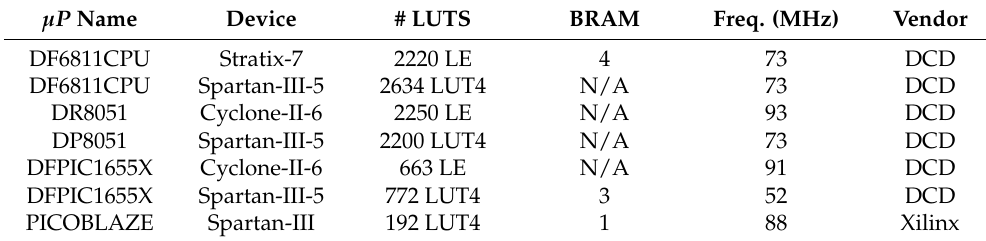
Table 2. FPGA 8-bitter implementation results.